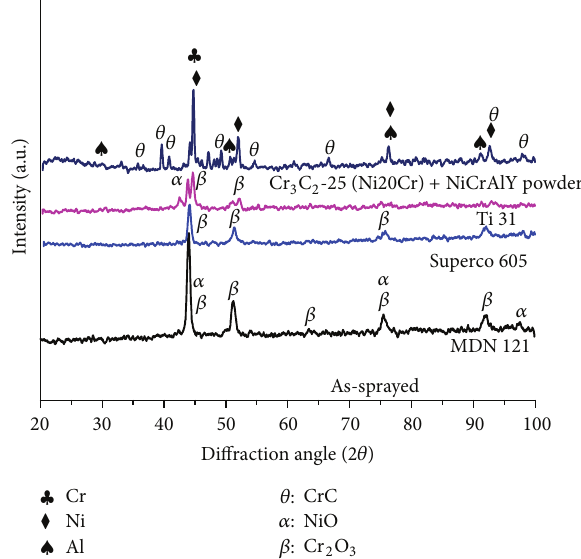
Figure 5: XRD profiles of mechanically blend 25% (Cr 3 C 2 - 25(Ni20Cr)) + NiCrAlY powder and HVOF sprayed coatings on three substrates are